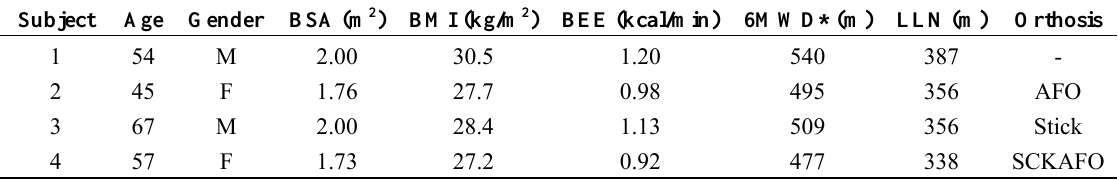
Table 1. Individual characteristics of the analysed subjects.